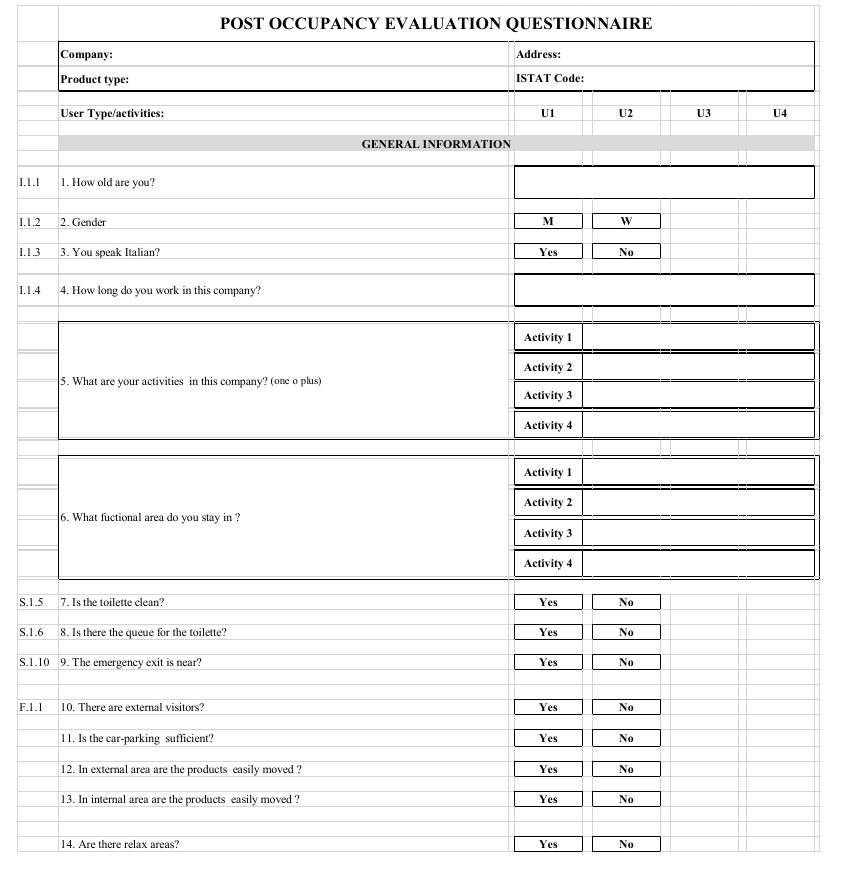
Figure 3. The first page of the questionnaire.